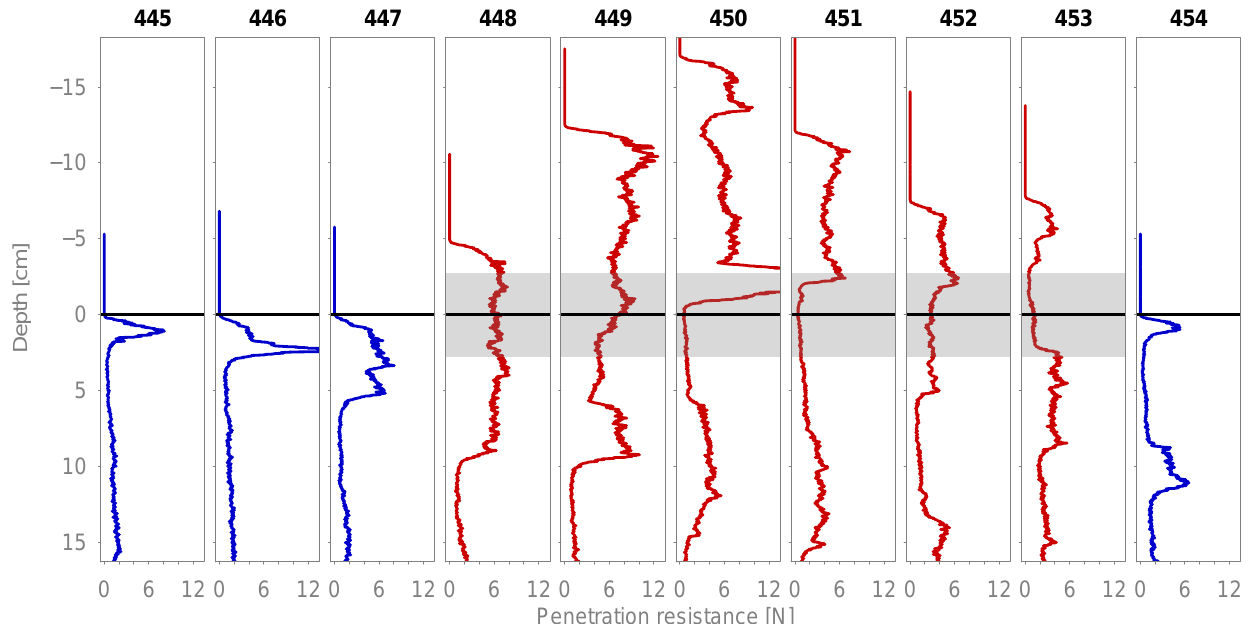
Figure 12. SMP profiles in transect 3 in Fig. 10. The subfigure titles indicate the SMP measurement IDs. See Fig. 10 for the corresponding position on the dune. Blue profiles indicate SMP measurements located next to the dunes; red profiles correspond to measurements on the dune. The profiles are aligned on the expected location of the old snow surface in the profiles. For the SMP measurements located next to the dune, the y -axis origin corresponds to the location of the snow surface. For the SMP measurements located on the dune, it corresponds to the expected location of the interface between newly deposited and old snow based on the TLS data. The grey areas show the uncertainty in the TLS data of ± 2 . 75cm